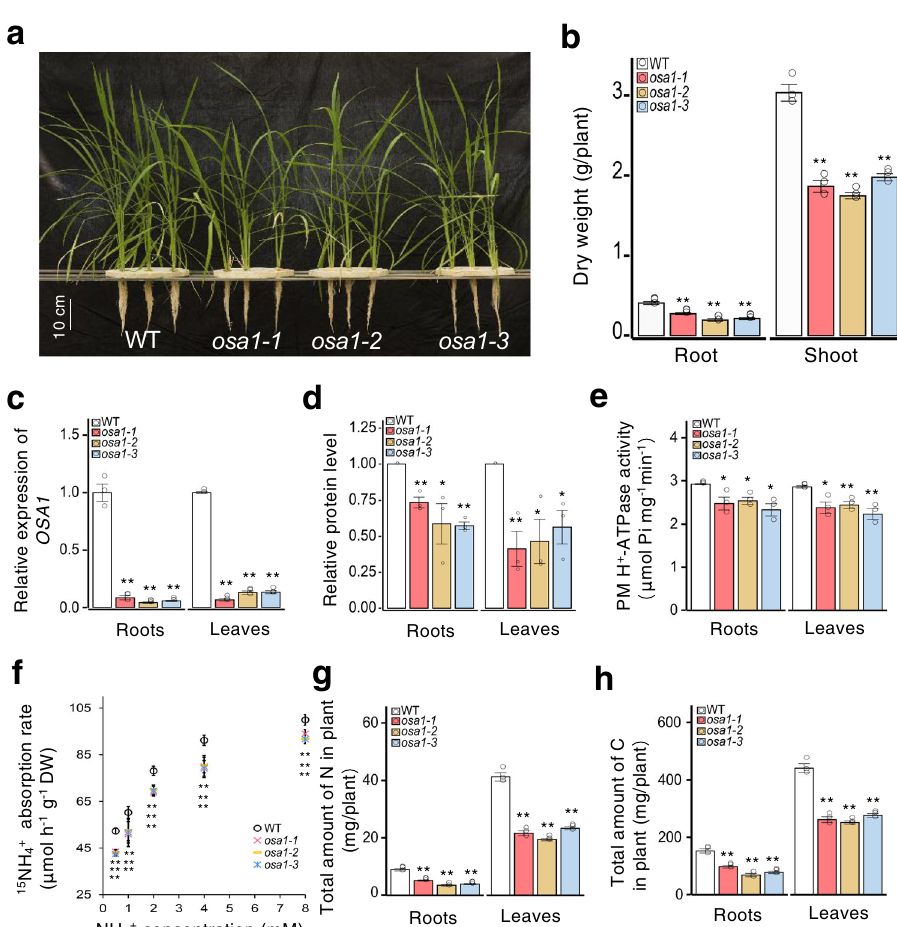
Fig. 3 osa1 mutant plants exhibit lower N uptake and decreased C content. a Phenotypes of WT and osa1 plants (scale = 10 cm). b Root and shoot dry weights of WT plants and osa1 mutants. c Relative expression levels of OSA1 in the roots and leaves of WT plants and osa1 mutants. d Relative PM H + - ATPase protein levels in the roots and leaves of WT plants and osa1 mutants. e ATP hydrolytic activity of PM H + -ATPase in WT plants and osa1 mutants. f 15 NH 4 + absorption rates in the roots of WT plants and osa1 mutants under different NH 4 + concentrations. The 15 NH 4 + absorption rate was determined after seedlings were incubated with 0.5 – 8 mM 15 NH 4 + for 5 min. g , h Total N and C levels in roots and leaves of WT plants and osa1 mutants. Plants were grown hydroponically in a greenhouse for 4 weeks; small circles in b – h represent data points for individual experiments; three biological replicates were analysed for each treatment. Values in b – h are presented as the means ± SEs ( n = 3). Differences were evaluated using the two-tailed Student ’ s t test (* P < 0.05; ** P < 0.01). The exact P values are provided in the Source Data fi